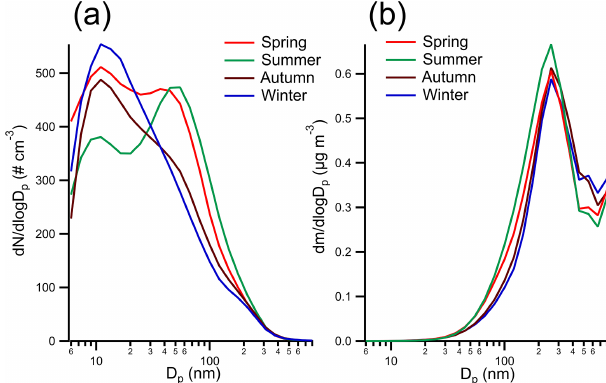
Figure 7. Seasonal variation in median particle number and mass size distributions (note that D p corresponds to the particle’s mobil- ity